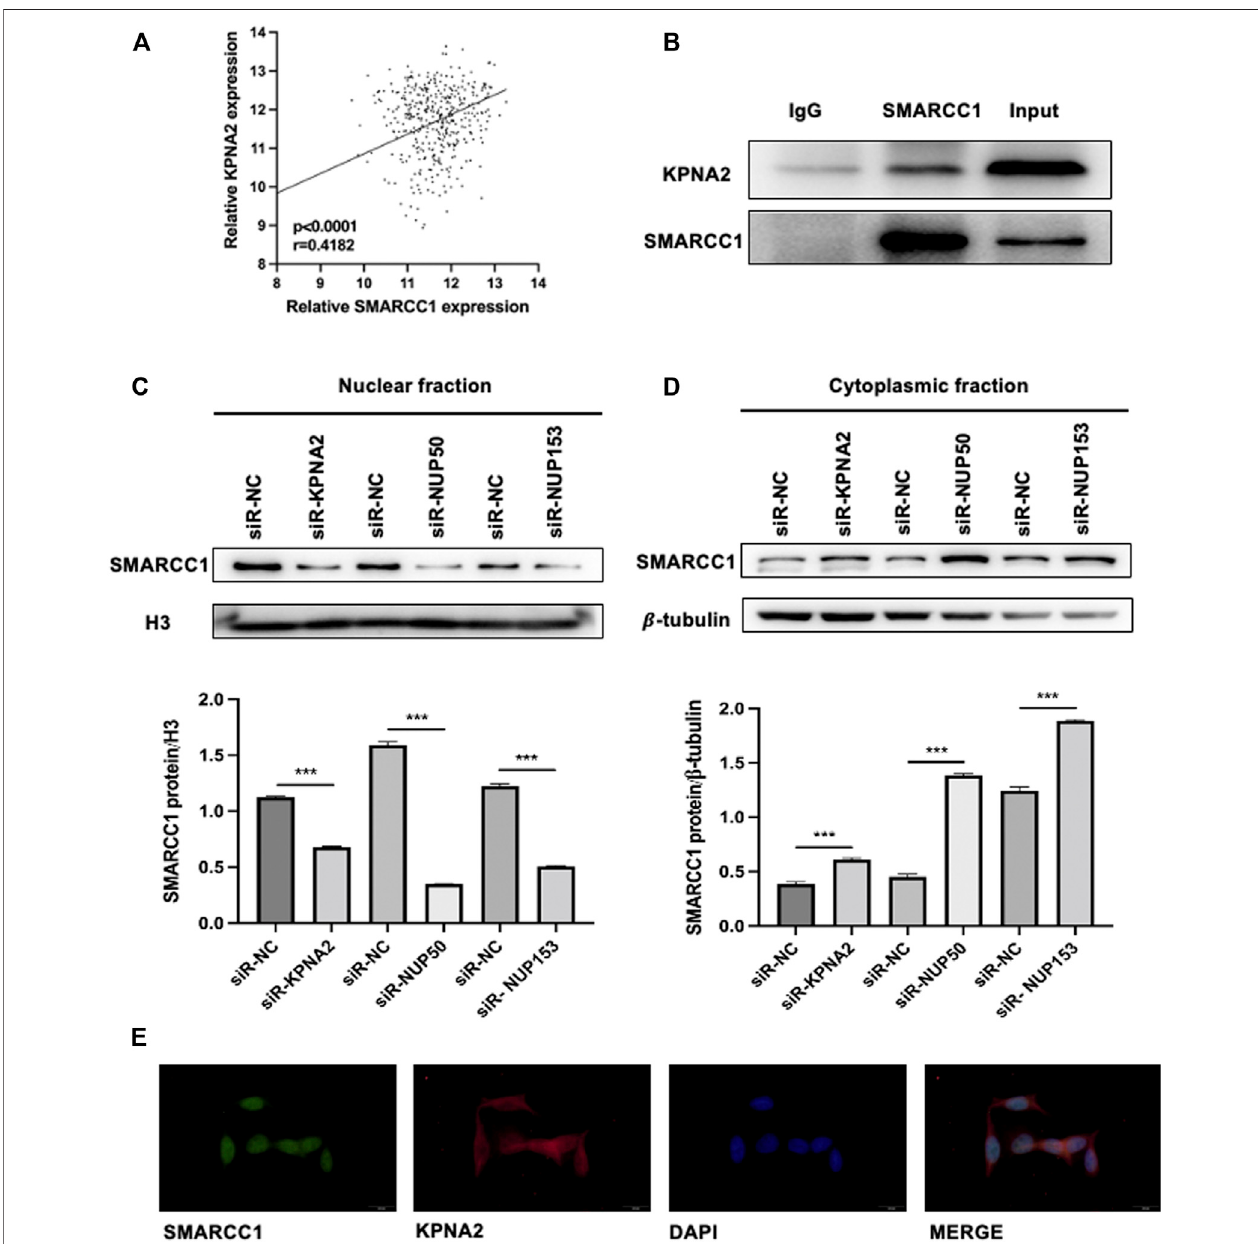
FIGURE 1| SMARCC1 isa cargo protein ofKPNA2 in BC cells. (A) Pearson ’ scorrelation analysis indicated a distinct positive correlation between SMARCC1 and KPNA2 expression. (B) A Co-IP assay was used to examine the association between KPNA2 and SMARCC1 in vitro . (C – D) After knockdown of KPNA2, Nup50 and Nup153, SMARCC1 expression was dramatically decreased in the nuclear fraction, while increased in the cytoplasmic fraction of UMUC-3 cell. (E) Representative immuno fl uorescence (IF) staining images, showing SMARCC1 (green) and KPNA2 (red) expression in the UMUC-3 cell in bladder cancer. Scale bar, 20 μ